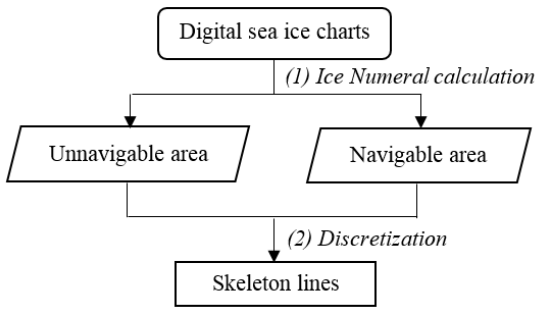
Figure 1. A two-stage solution to automatic ice navigation.